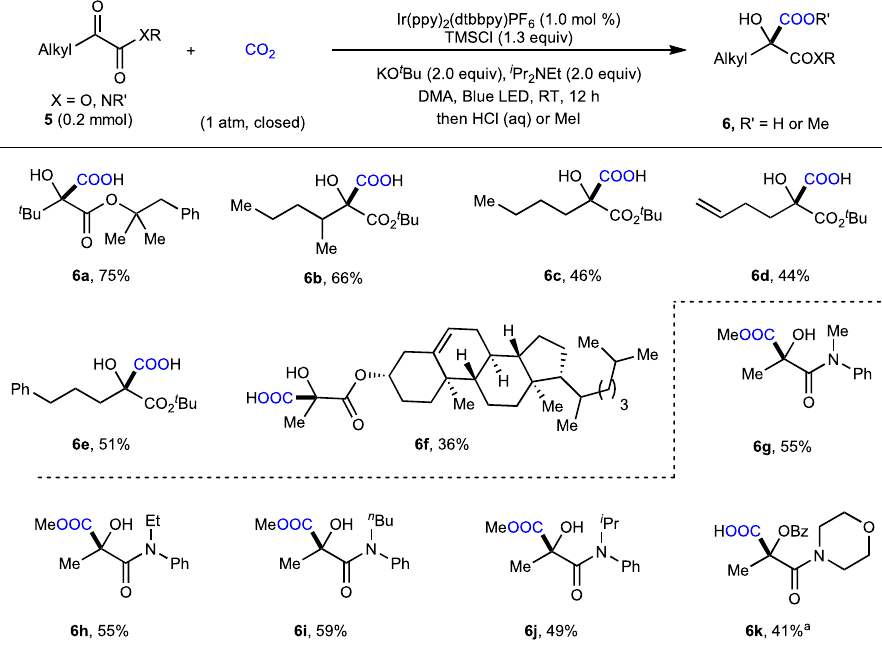
Fig. 6 Substrate scope of α -ketoesters and α -ketoamides. The standard conditions were used, as shown in Fig. 3, entry 7. Isolated yields of corresponding carboxylic acids or methyl esters 6 are shown. a Isolated yield of corresponding benzoate ester upon work up with BzCl. Bz